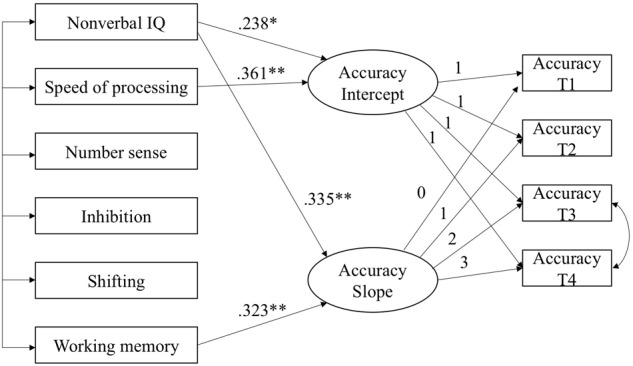
Predicting the intercept and slope in arithmetic accuracy. Model Fit: χ2 = 14.97, df = 16, p = 0.53, CPI = 0.935, TLI = 1.010, RMSEA = 0.000, ∗p < 0.05, ∗∗p < 0.01.